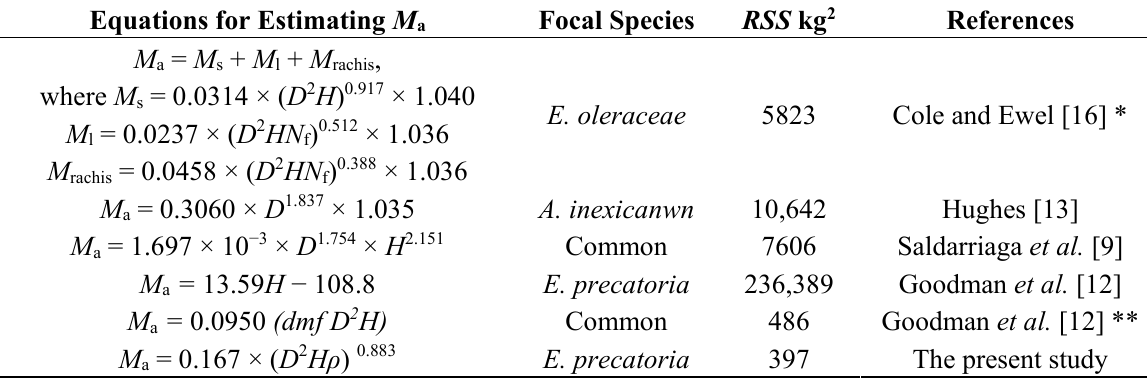
Table 2. The comparisons of allometric models for estimating above-ground mass M a of palm species among the models developed in different regions, and the residual sum of squares RSS was calculated for each